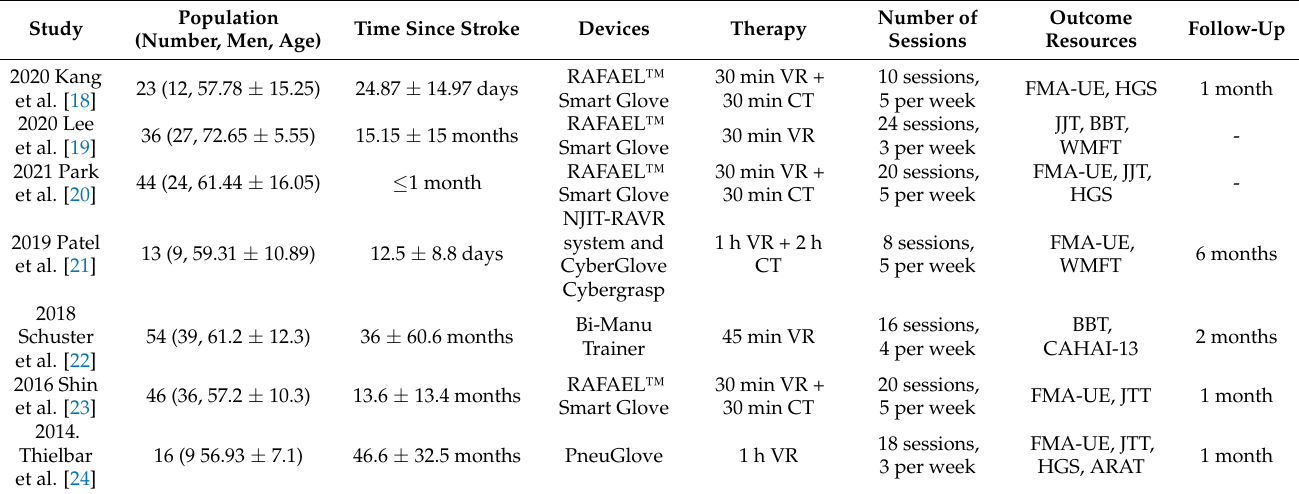
Table 1. Subjects and intervention